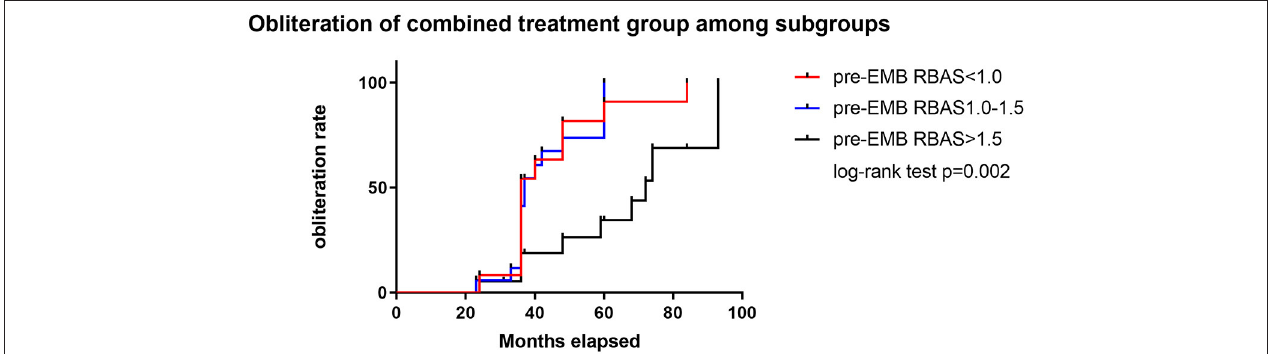
FIGURE 2 | Subgroup analysis of RBAS before EMB for the combined treatment group. Kaplan–Meier analysis showed significant difference between subgroups in obliteration rate; RBAS > 1.5 is significant with lower obliteration rate than the other two groups (log-rank test, p = 0.002).